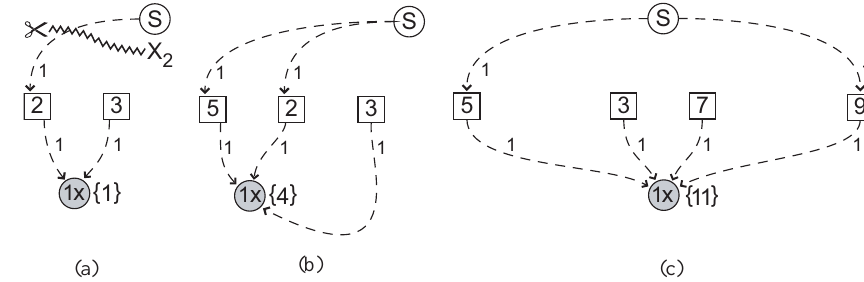
Figure 9. Pruned graphs for each of the four special shared